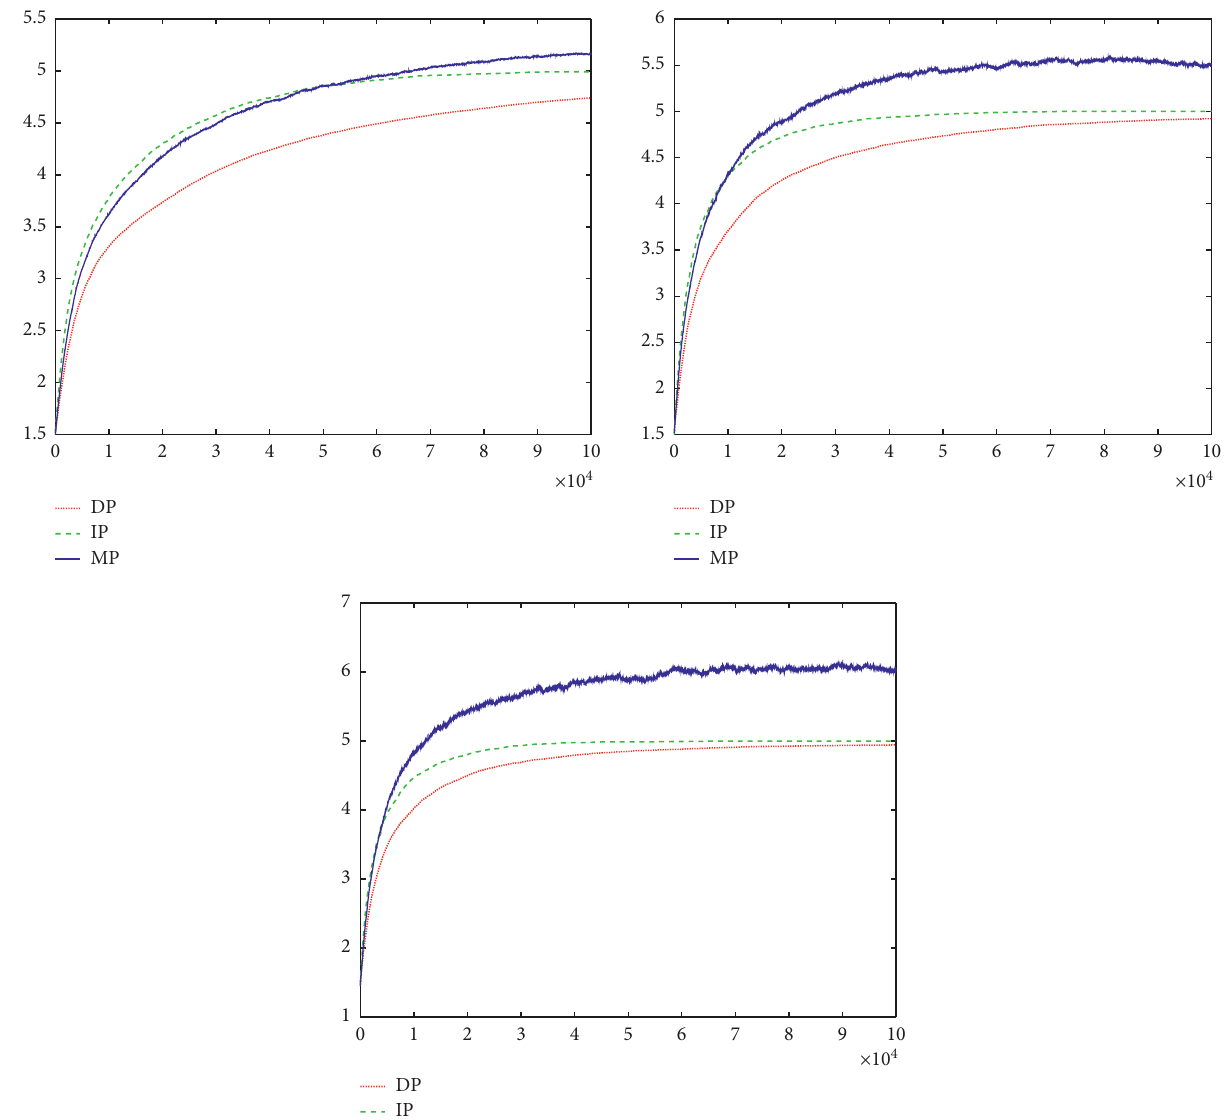
Figure 10: Average knowledge levels in a small-world network when L � 2, 6, and